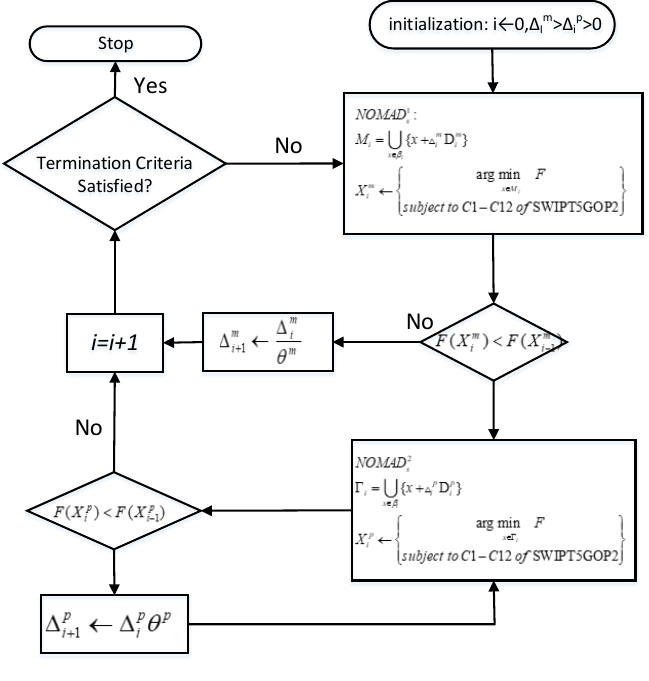
Figure 3. MADS flow